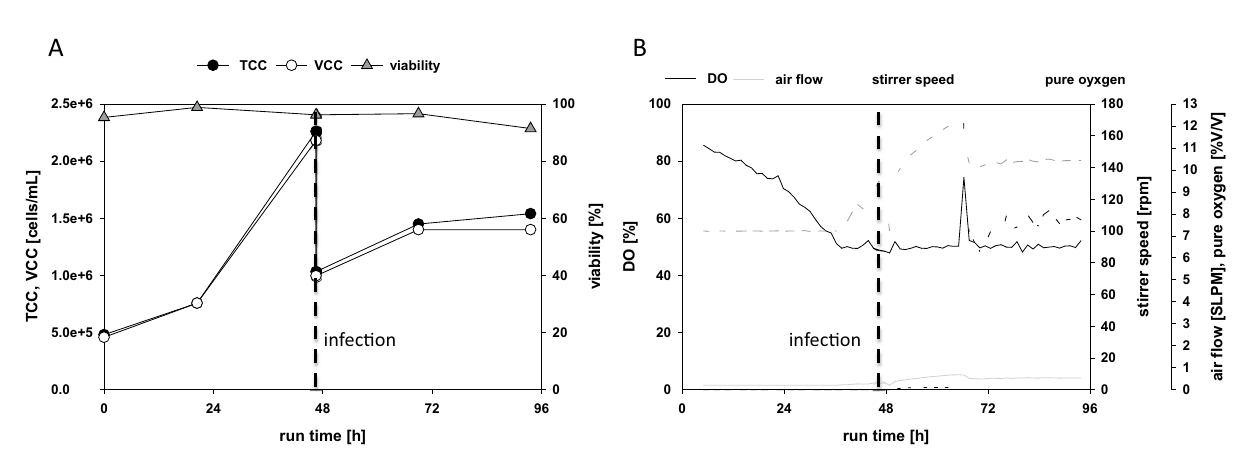
Figure 3. Reference process with TN42 insect cells. ( A ) Counts of total cells (TCC, filled symbols) and viable cells (VCC, open symbols), before and after infection (dashed line), and cell viability (triangles) over the course of the cultivation. ( B ) Trends are shown for the dissolved oxygen (DO)-level, the airflow, the stirrer speed, and the percentage of pure oxygen in the airflow. The time point of infection is indicated by the vertical bold dashed